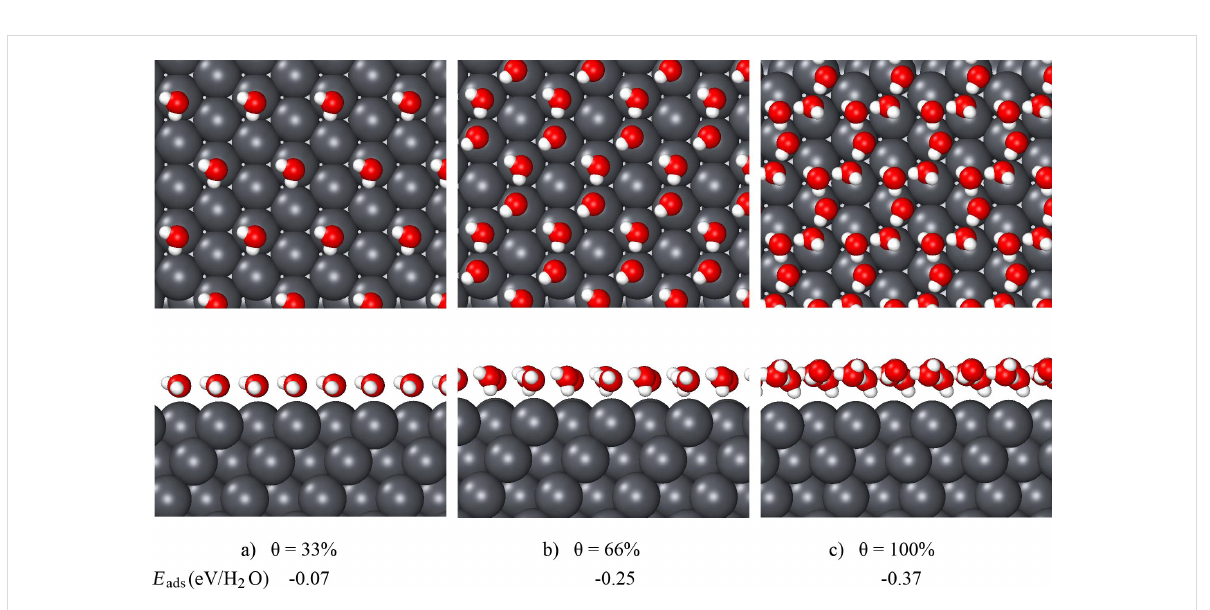
Figure 1: Top and side views of water structures on Pb(111) at different coverages, θ . The Pb, O and H atoms are colored in grey, red and white, re- spectively. The adsorption energies are shown at the bottom of the panels. In panel a, the periodic images of the water molecules have been